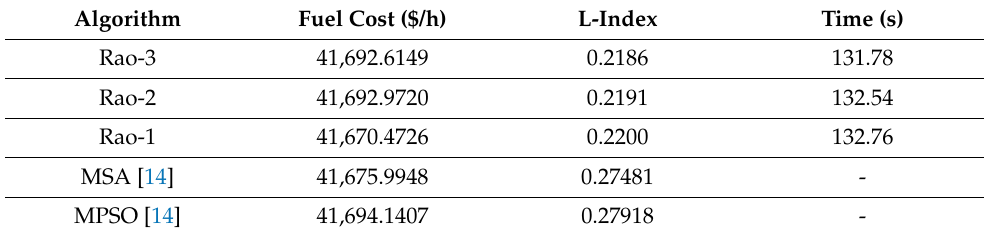
Table 15. Case 9: VSE results in the IEEE 57-bus